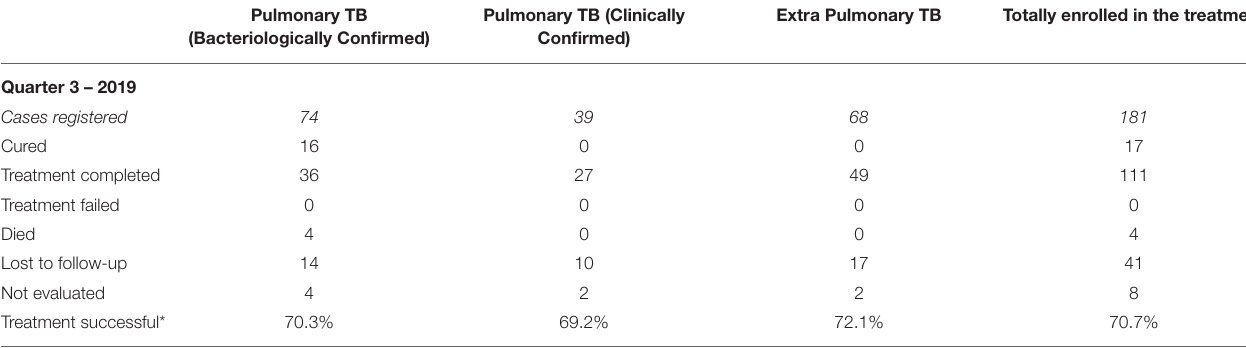
TABLE 4 | Tuberculosis treatment outcomes in cohort of patients who started treatment regimen the in third quarter of 2019.